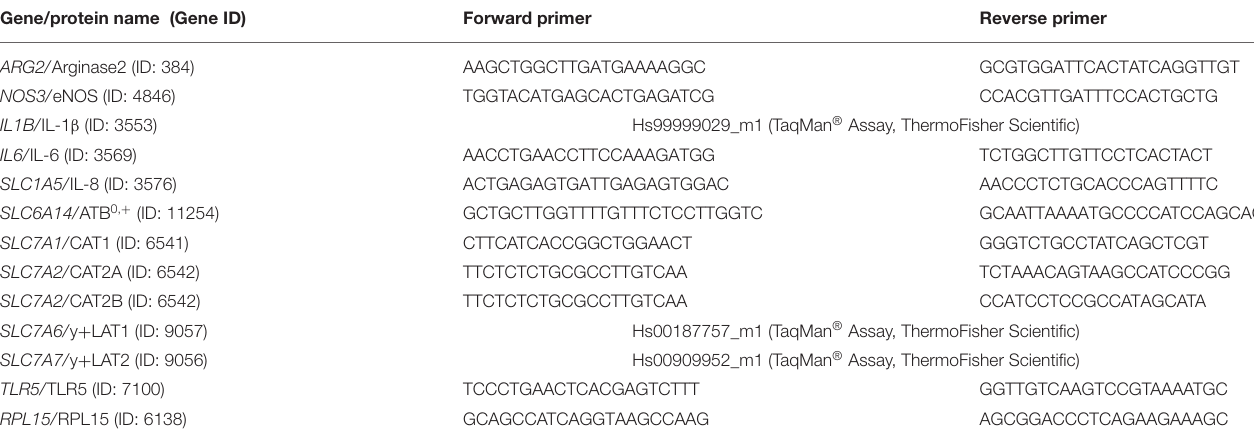
TABLE 1 | Sequences of the primer pairs employed for real-time quantitative PCR (RT-qPCR) analysis. Gene/protein name (Gene ID) Forward